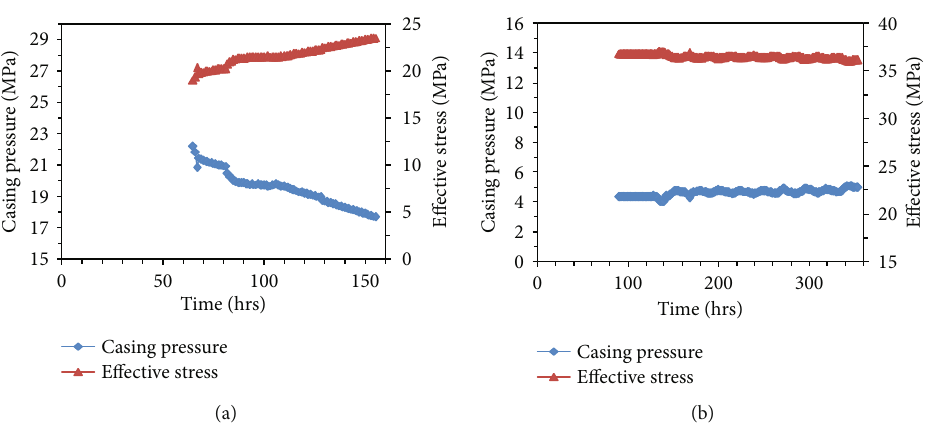
Figure 7: Casing pressure and e ff ective stress changed with time for two wells in shale gas formations belonging to southern Sichuan. (a) Well 3 and (b) Well 4.